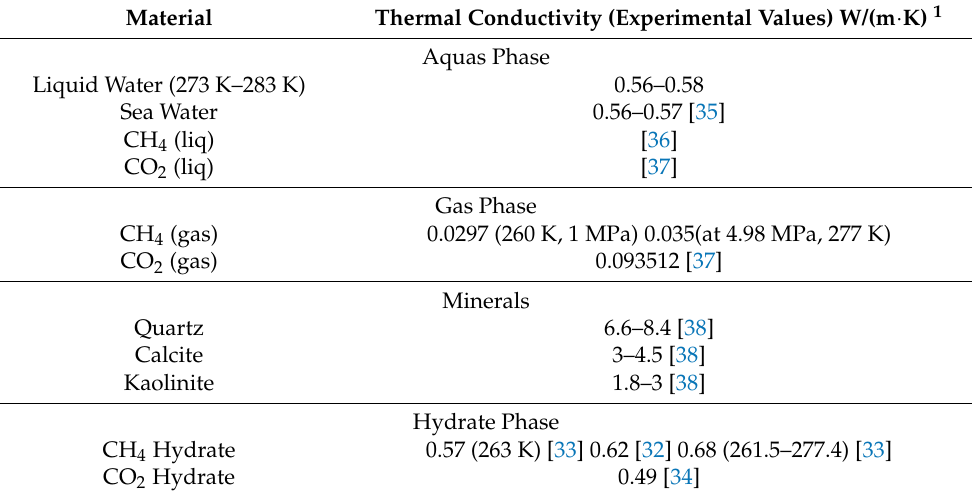
Table 2. Thermal conductivity of different hydrate components in various phases.